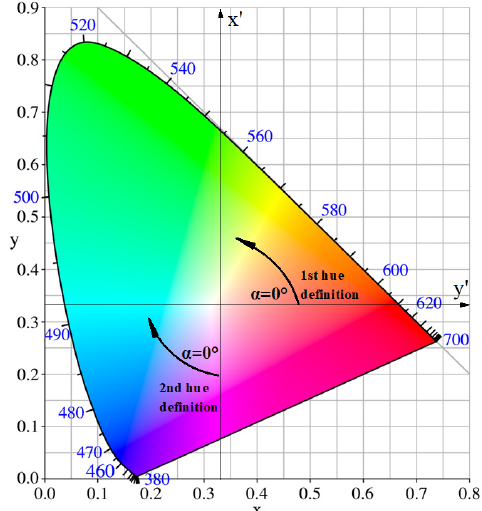
Figure 2. The CIE 1931 chromaticity diagram. The white point located at (x, y) = (1/3, 1/3). The first hue definition is the angle between the vector to a point and the positive y’-axis (at y = 1/3), giving higher angles in an anti-clockwise direction [36] ; the second hue definition is the angle between the vector to a point and the negative x’-axis (at x = 1/3), giving higher angles in a clockwise direction [37] .